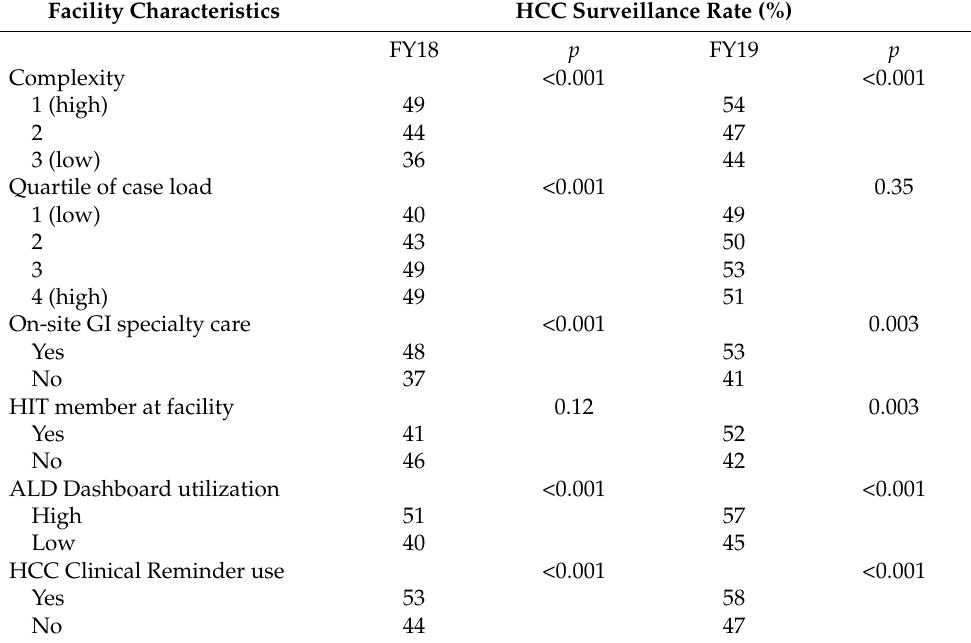
Figure 2. Proportion of Veterans receiving hepatocellular carcinoma surveillance in fiscal year 2018, by facility. Table 2. HCC surveillance rates in fiscal years 2018 and 2019 by facility